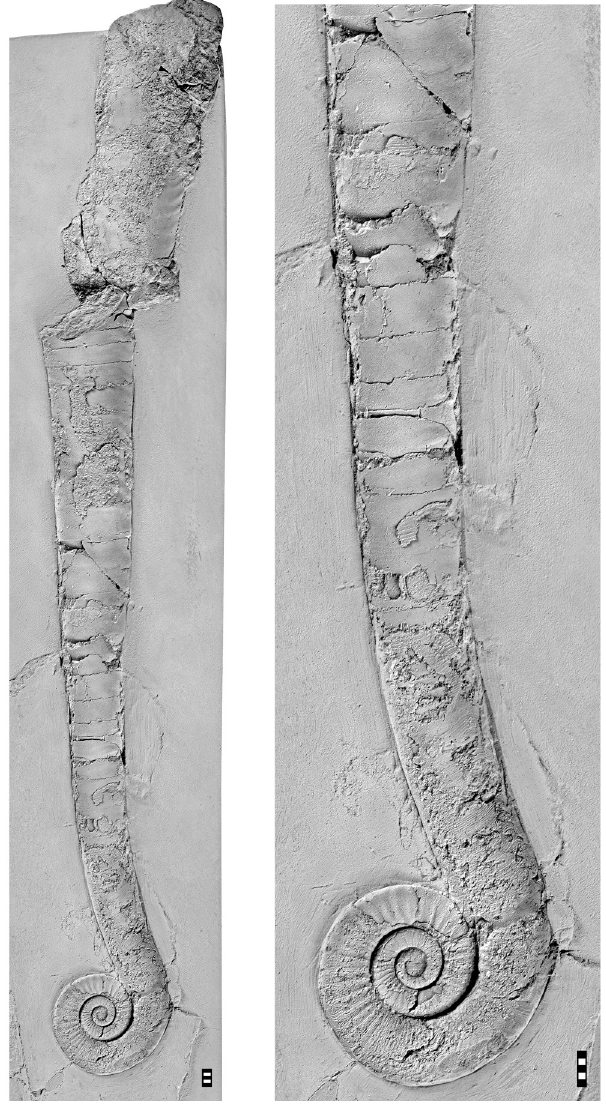
Fig. 32. Lituites lituus de Montfort, 1808 from the Upper Grey Orthoceratite Limestone; specimen MB.C.11990 (Helms 1966 Coll.) from Groß Zicker (Island of Rügen, Mecklenburg-Vorpommern). Scale bar units = 1